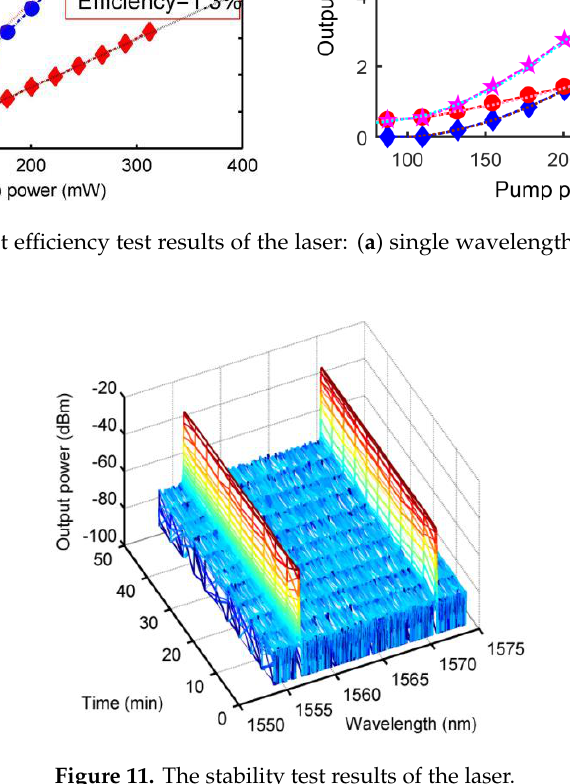
Figure 10. The output efficiency test results of the laser: ( a ) single wavelength output and ( b ) dual- wavelength output.